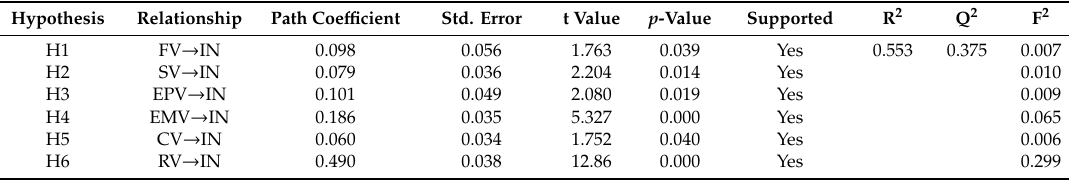
Table 6. Results of SEM and Hypothesis